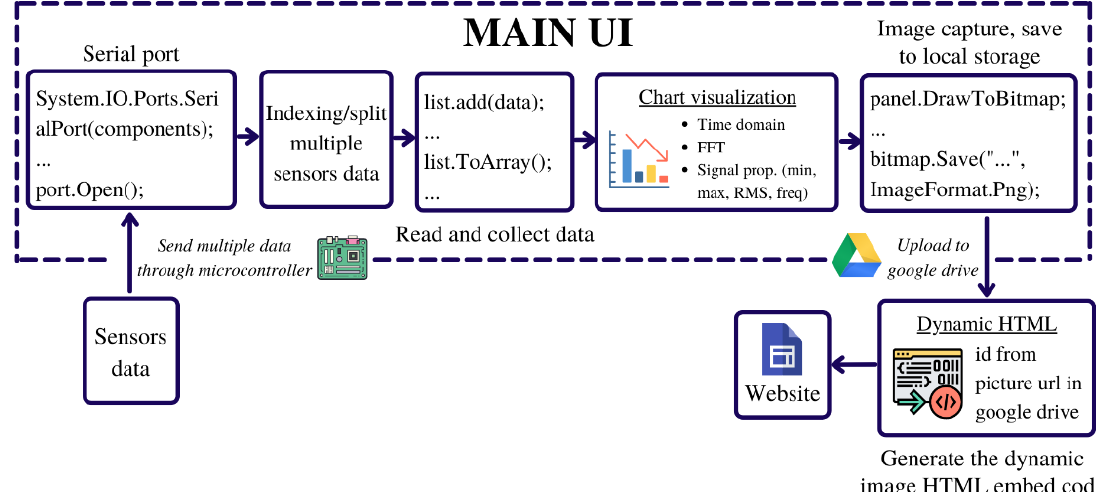
Figure 6. Working process of the system.